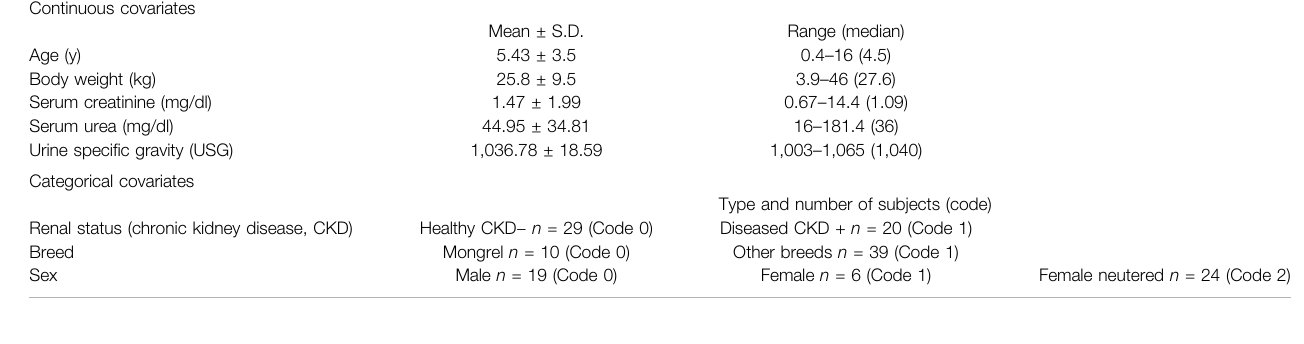
Categorical covariates